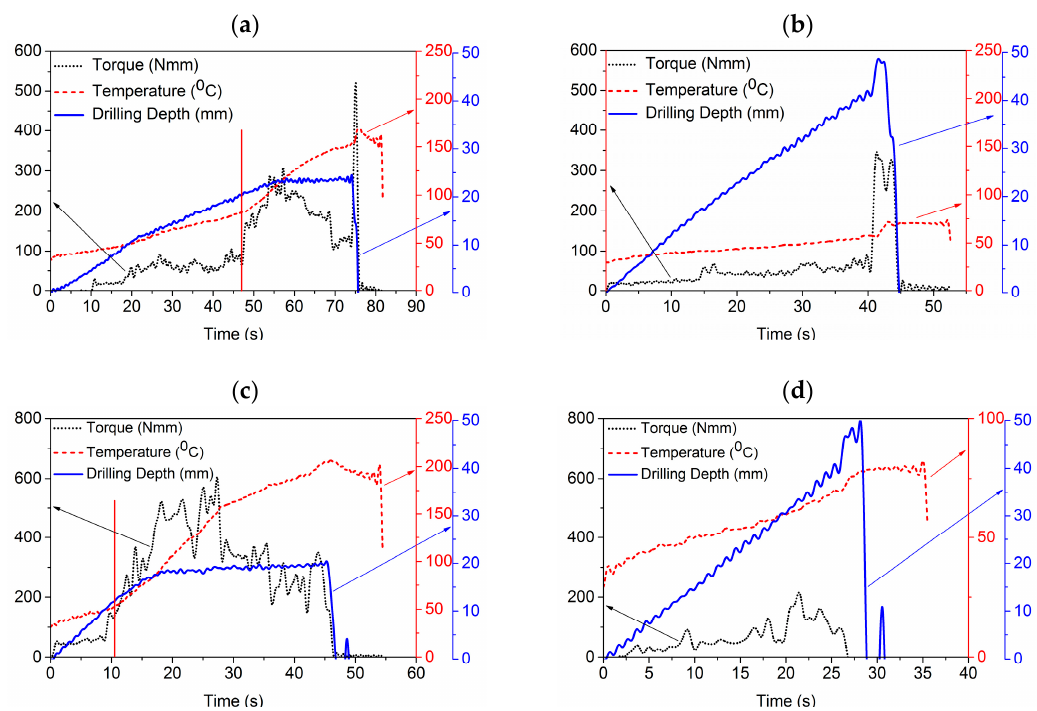
Figure 8. Time histories of cutting torque, temperature, and drilling depth with respect to time in CD ( a , c ) and UAD ( b , d ) with conditions of axial force of 6 kgf, hole 4 ( a , b ) and 12 kgf, hole 5 ( c , d ).